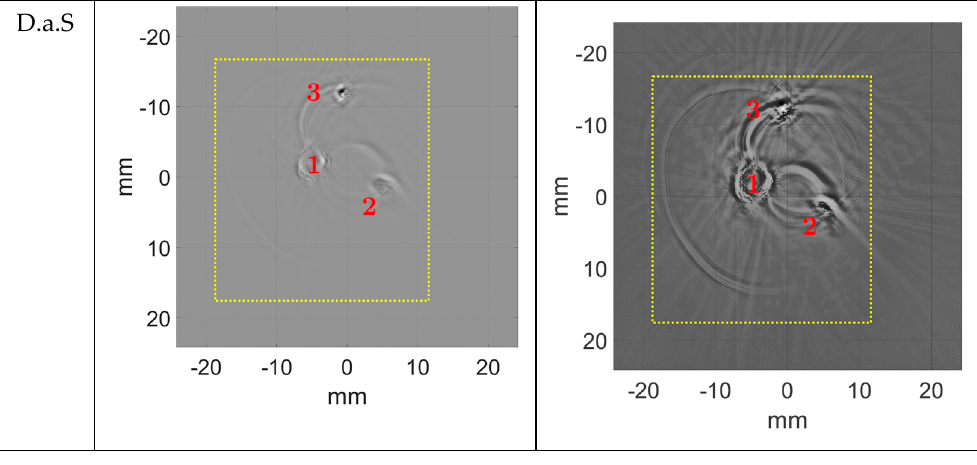
Figure 11. Reconstruction of the newborn arm phantom (True Phantom Solutions) (H2) obtained using reflection-mode USCT algorithm in pulse-mode ( left ) and WCE-mode ( right ), with 720 signals and 65,536 samples per signal. Image size: 2048 × 2048 pixels 2 . The dotted square is the area where the contrast-to-noise ratio was calculated.